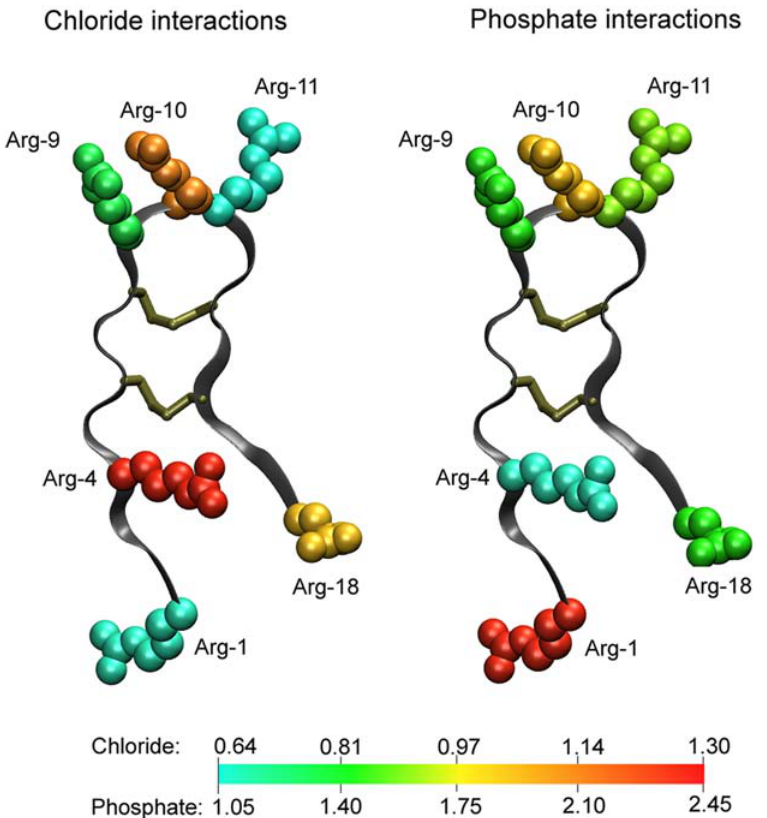
Figure 4. Interaction of arginine residues with phosphate groups and chloride ions. The numbers on the colour scales correspond to the number of phosphate groups/chloride ions within 7.5 A˚ of the f -carbon of the respective arginine residue. Data are averaged over the last 50 ns of the molecular dynamics simulation, as well as over the eight peptides.